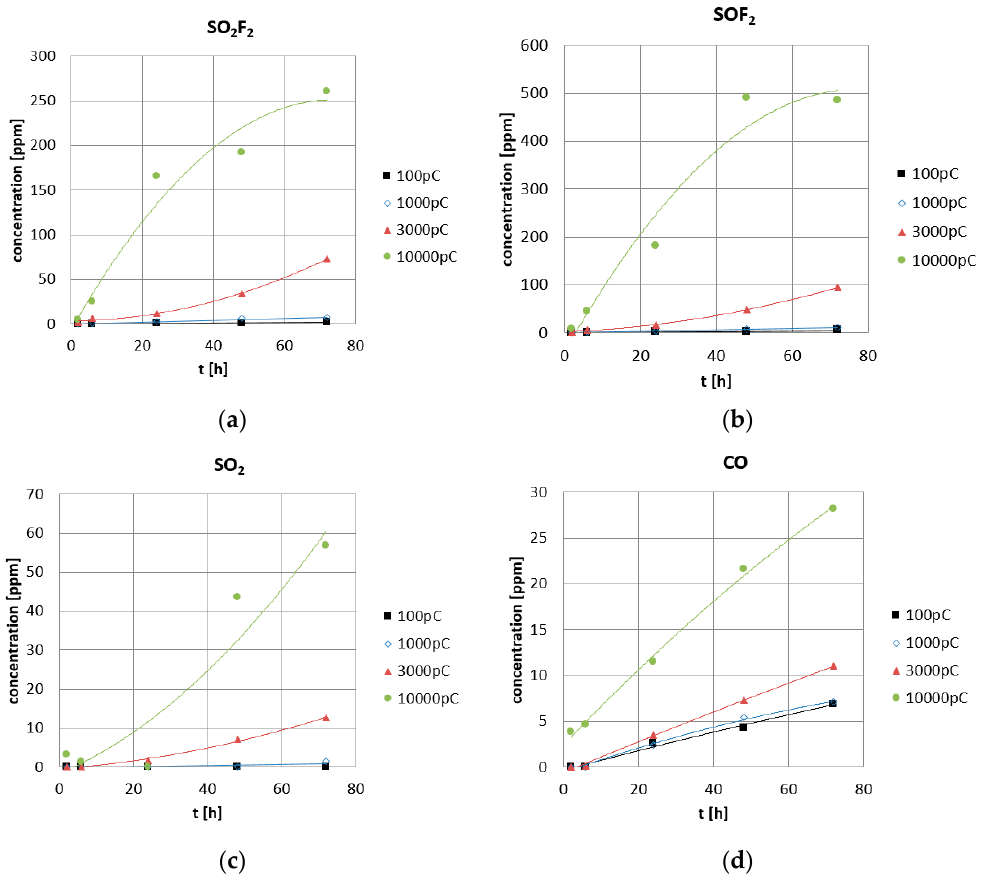
Figure 5. Concentrations of the decomposed gases according to partial discharge magnitude ( a ) SO 2 F 2 , ( b ) SOF 2 , ( c ) SO 2 , and ( d ) CO.